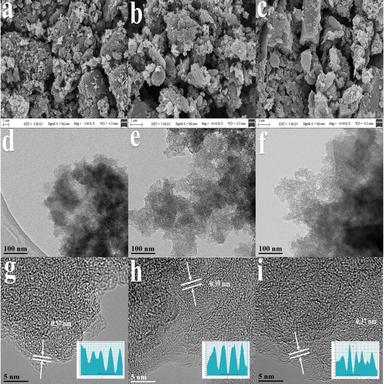
a-c) SEM, d-f) TEM and g-i) HRTEM images of DAAQ-S/N-C-750, DAAQ-S/N-C-850, and DAAQ-S/N-C-950 electrode materials.